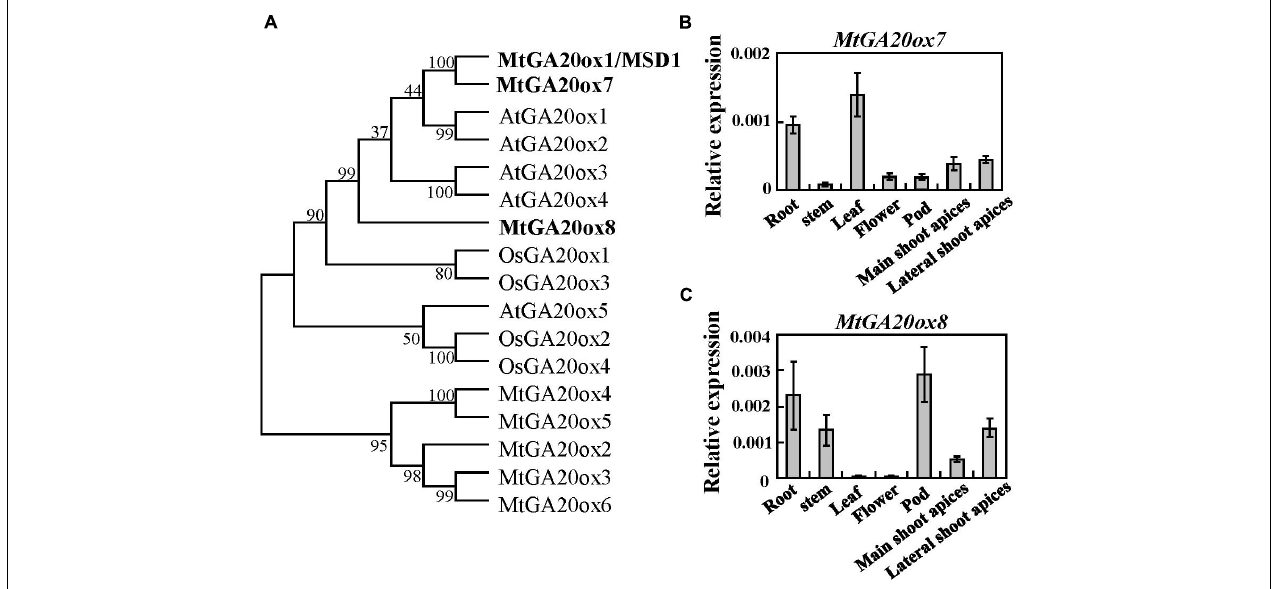
FIGURE 4 | Phylogenetic analysis of MSD1 and its closely related homologs. (A) Phylogenetic analysis of MSD1 and its homologs in M. truncatula (Mt), Arabidopsis (At) and rice (Os). Numbers on branches indicate bootstrap percentages for 1,000 replicates. (B,C) MtGA20ox7-1 and MtGA20ox8 transcript levels in different tissues, as revealed by quantitative RT-PCR. MtActin was used as an internal control. Values are means ± SD of three technical replicates. Three independent experiments were performed, with similar